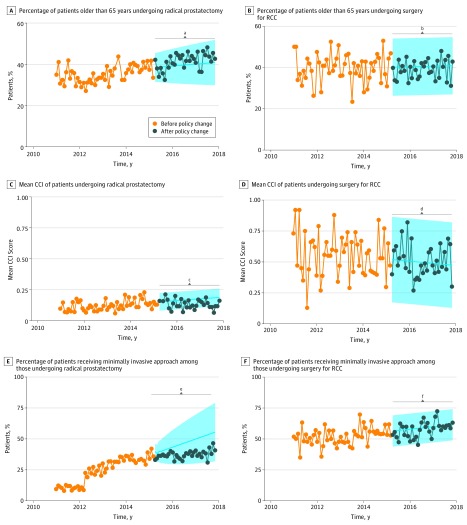
Proportion of Patients Older Than 65 Years, Mean Charlson Comorbidity Index (CCI) Score, and Proportion of Patients Receiving Minimally Invasive Approach Among 17 159 Patients Undergoing Radical Prostatectomy and 5762 Patients Undergoing Surgery for Renal Cell Carcinoma (RCC)The shaded areas represent the predicted 95% CIs, and the P values are based on a step function with a 0-order response.aP = .82.bP = .75.cP = .73.dP = .15.eP = .19.fP = .80.